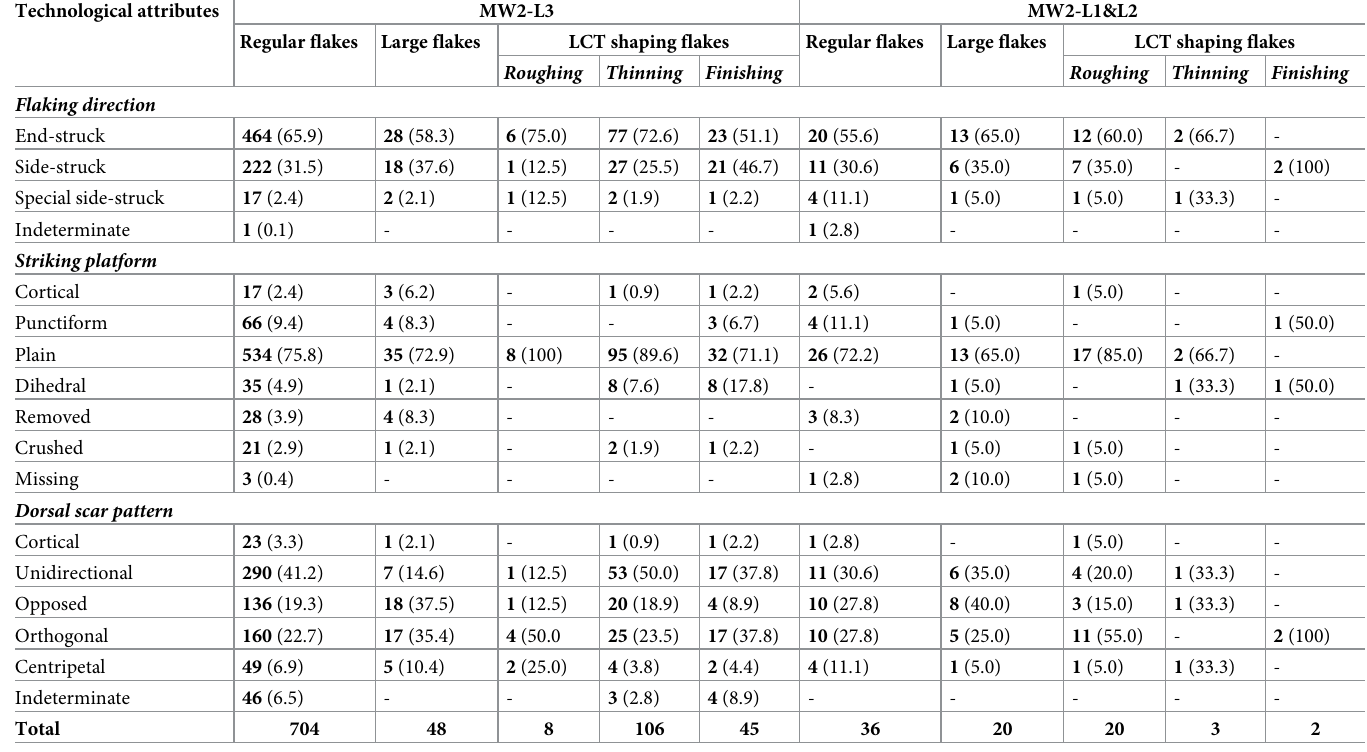
Table 7. Absolute and relative frequencies (in parentheses) of the technological features of flake categories in the MW2 assemblages. Technological